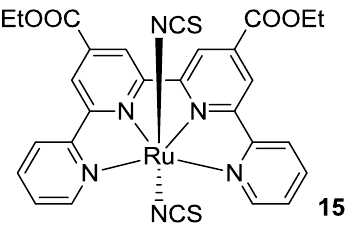
Figure 12. The first qtpy complex applied in DSCs by Renouard et al. [90].